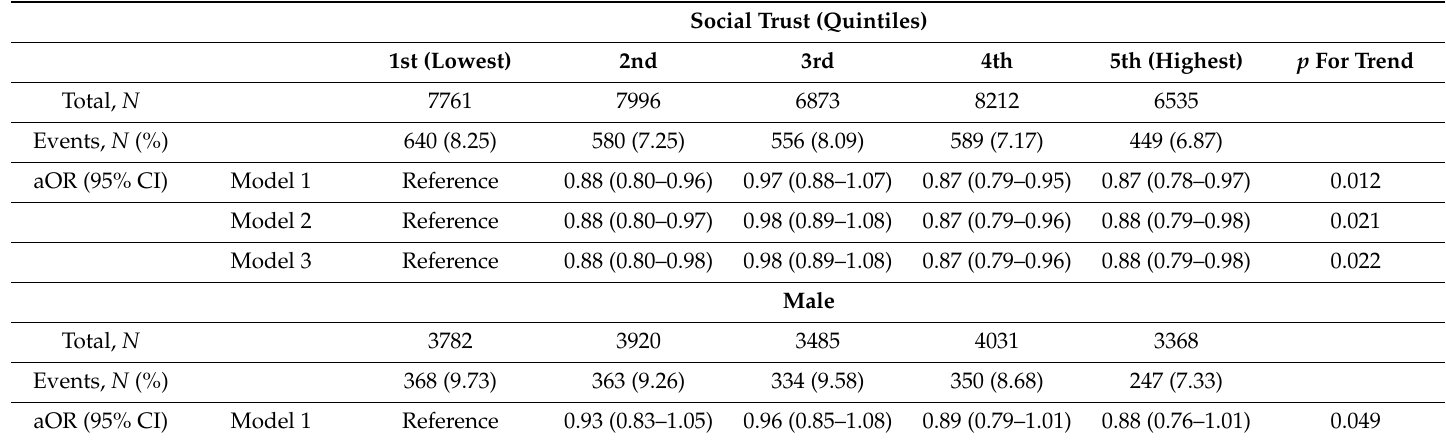
Table 2. Adjusted odds ratio (95% confidence intervals) for metabolic syndrome based on the NCEP ATP III criteria by social trust